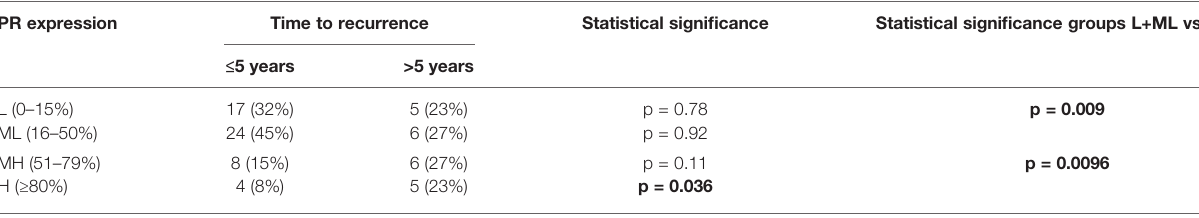
TABLE 8 | PR expression and time to recurrence (75